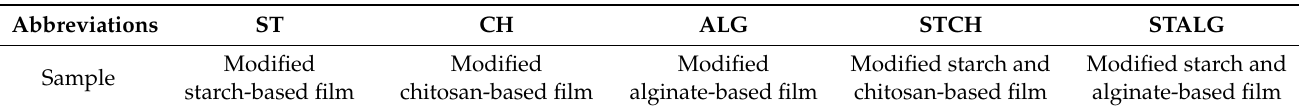
Table 1. Abbreviations of samples investigated in this